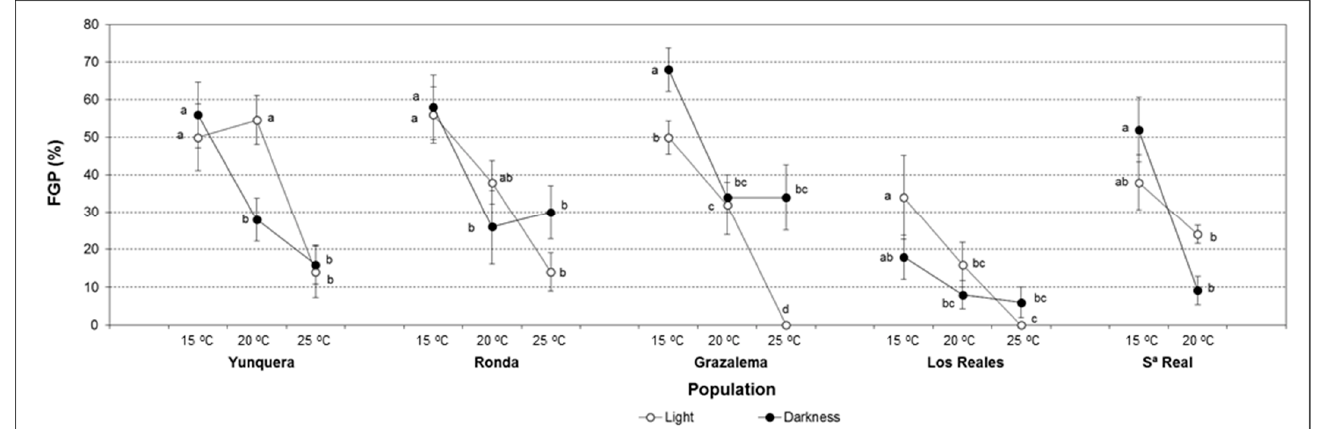
Figure 1. The effect of temperature and light on FGP of A. pinsapo seeds from different provenances. Data represent the mean ± SEM. Different letters within each population indicate significant differences by the LSD test with a significance level of 0.05.